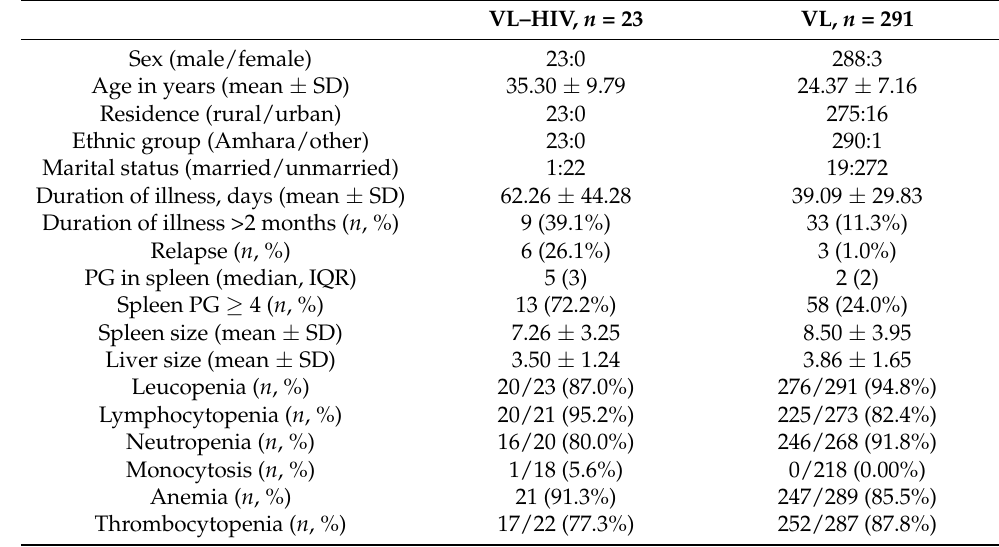
Figure 1. Data collection flowchart of VL patients (LRTC, Gondar, Ethiopia). Table 1. Subject characteristics and clinical data among VL patients with and without HIV coinfection at the LRTC, Gondar,